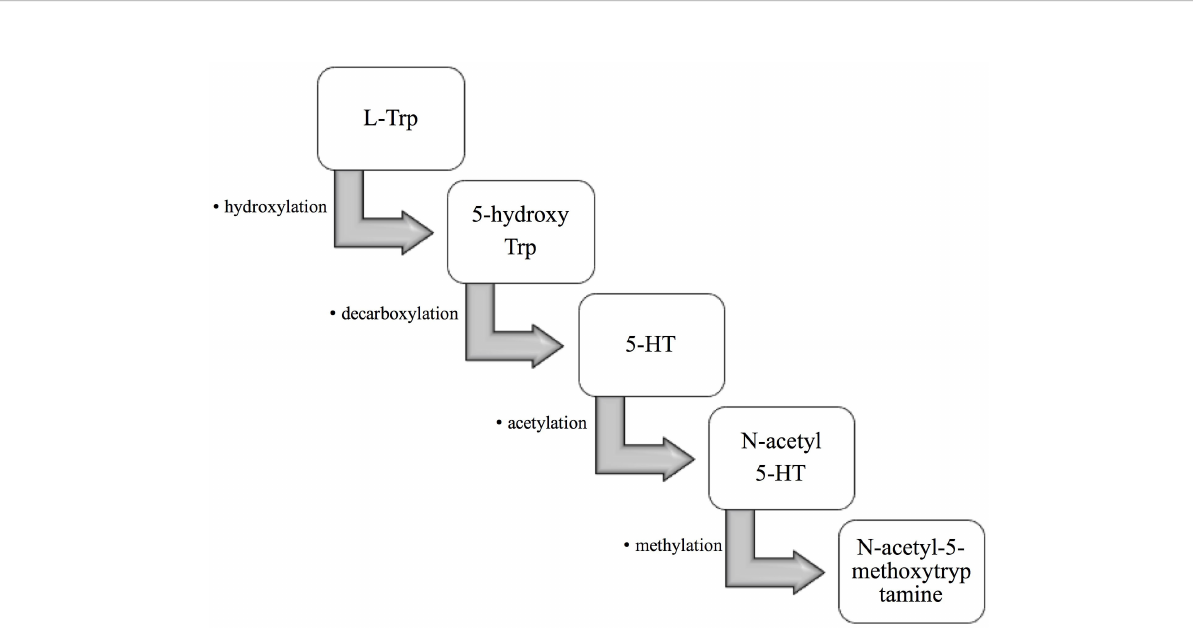
FIGURE 1 The formation of melatonin in the organism. First, L-tryptophan (L-Trp) is hydroxylated to 5-hydroxytryptophan (5-hydroxy Trp). 5-hydroxy Trp is then decarboxylated to 5-hydroxytryptamine (5-HT), which is then acetylated to N-acetyl-5-hydroxytryptamine (N-acetyl 5-HT). Finally, N- acetyl 5-HT is methylated to N-acetyl-5-methoxytryptamine, also known as